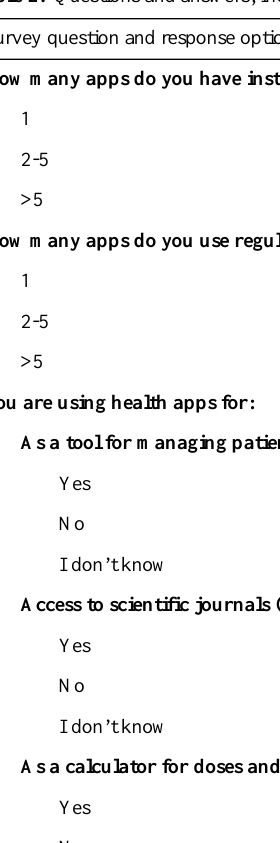
Table 2. Questions and answers, including information about the features and use of health apps by nurses for professional